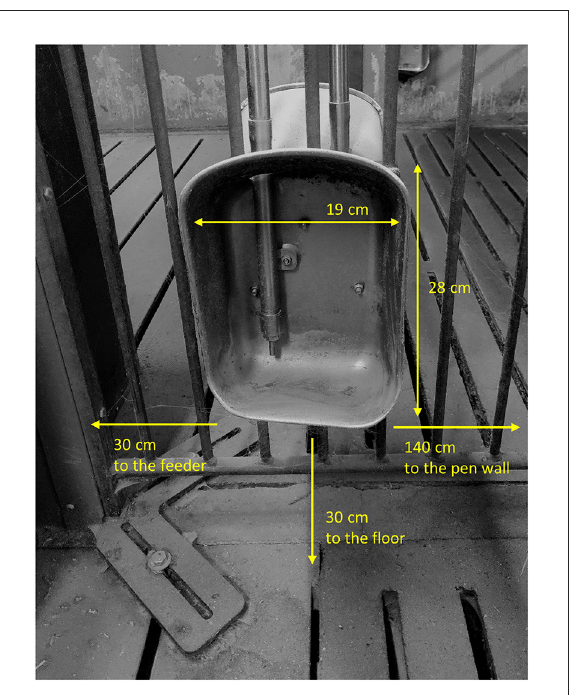
FIGURE2 Design and dimensions of the drinking